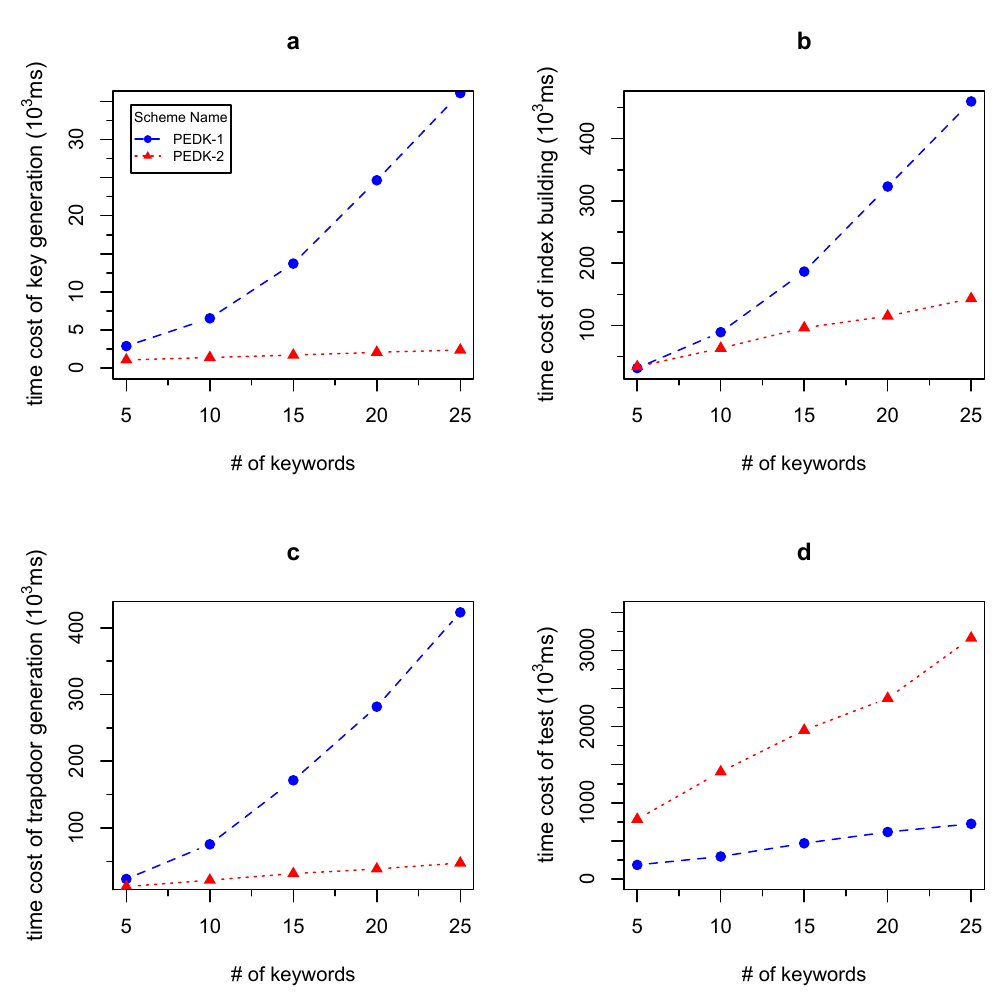
Figure 3. Impact of n on the time cost of key generation ( a ), index construction ( b ), trapdoor generation ( c ) and testing ( d ) in PEDK-1 and PEDK-2. ( D = 100, m = 5, n = { 5,10,15,20,25 }